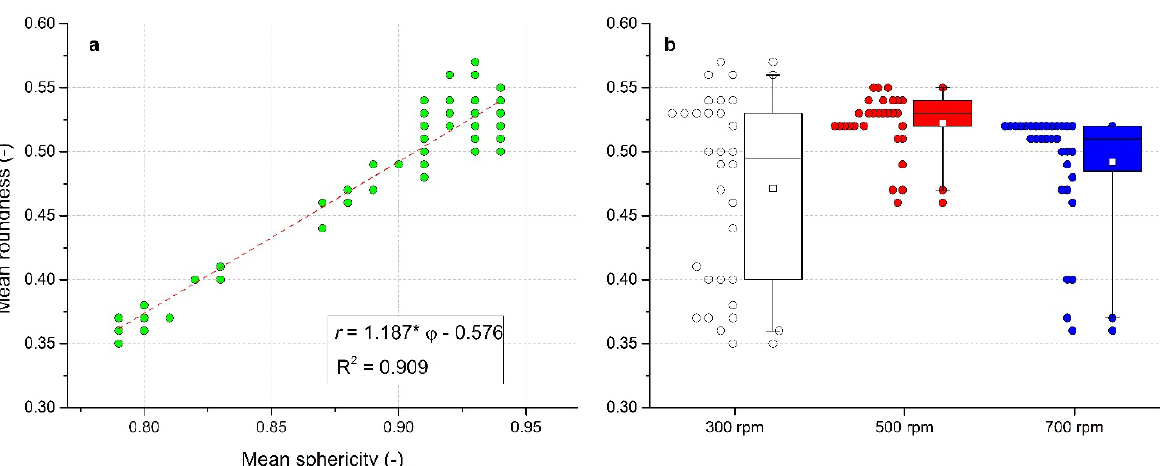
Figure 7. Evaluation of the aspect ratio for impeller speeds of 300, 500, and 700 rpm: ( a ) effect of the L/S ratio on aspect ratio, ( b ) box charts of aspect ratio for different impeller speeds.